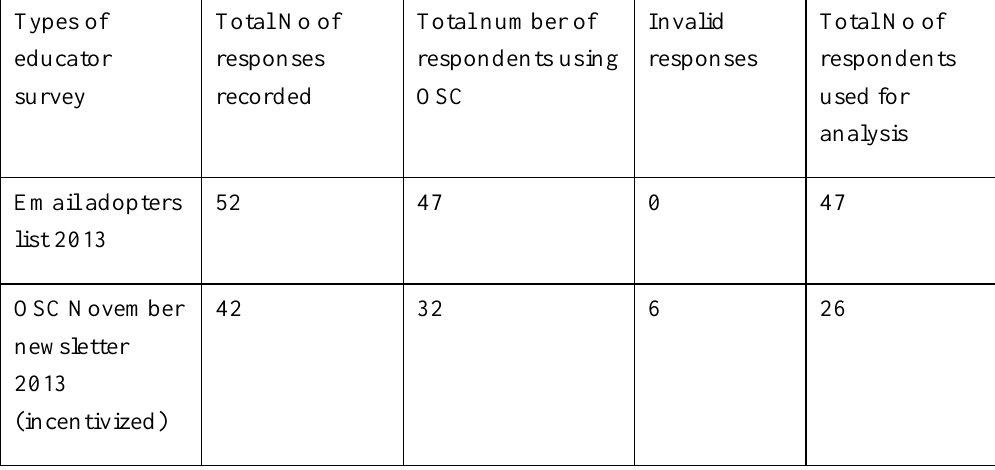
Responses to Educator Questionnaire Types